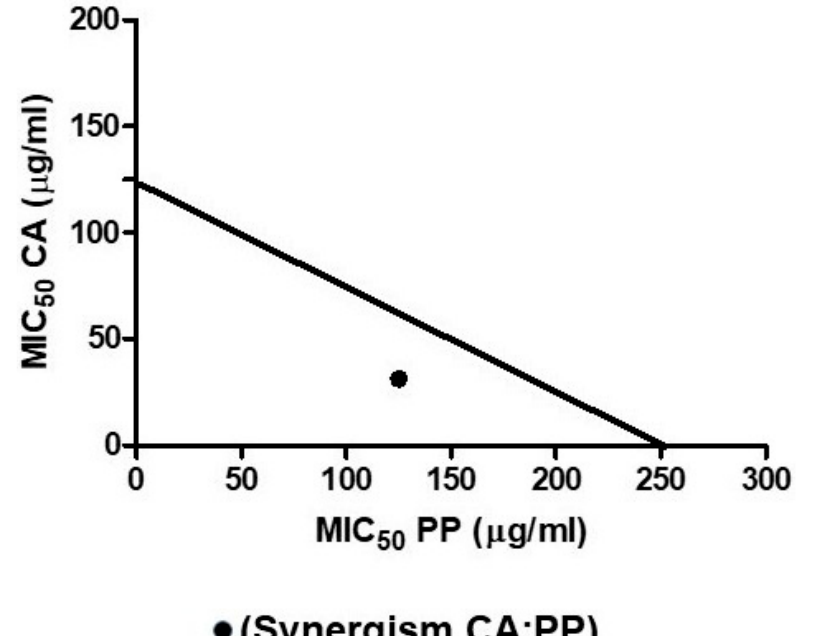
Figure 4. Isobologram plot showing the synergistic action of CA and PP on the C. albicans SC5314 strain. The individual MIC 50 values calculated for CA and PP are represented on the Cartesian axes. The combination of both compounds gives rise to a point that falls inside in the right triangle obtained by drawing the line that joins the MICs of the individual agents.